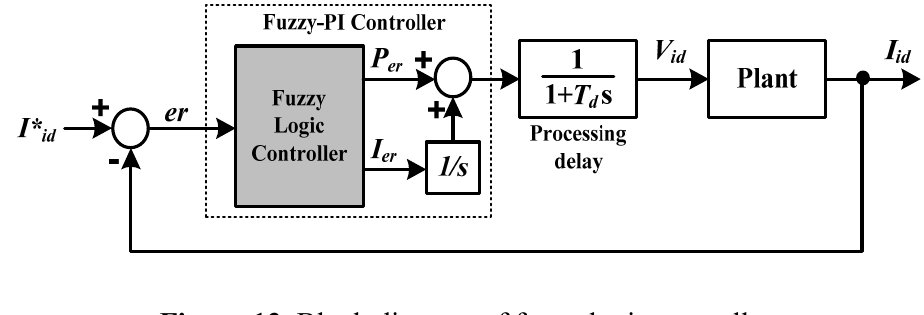
Figure 13. Block diagram of fuzzy logic controller.